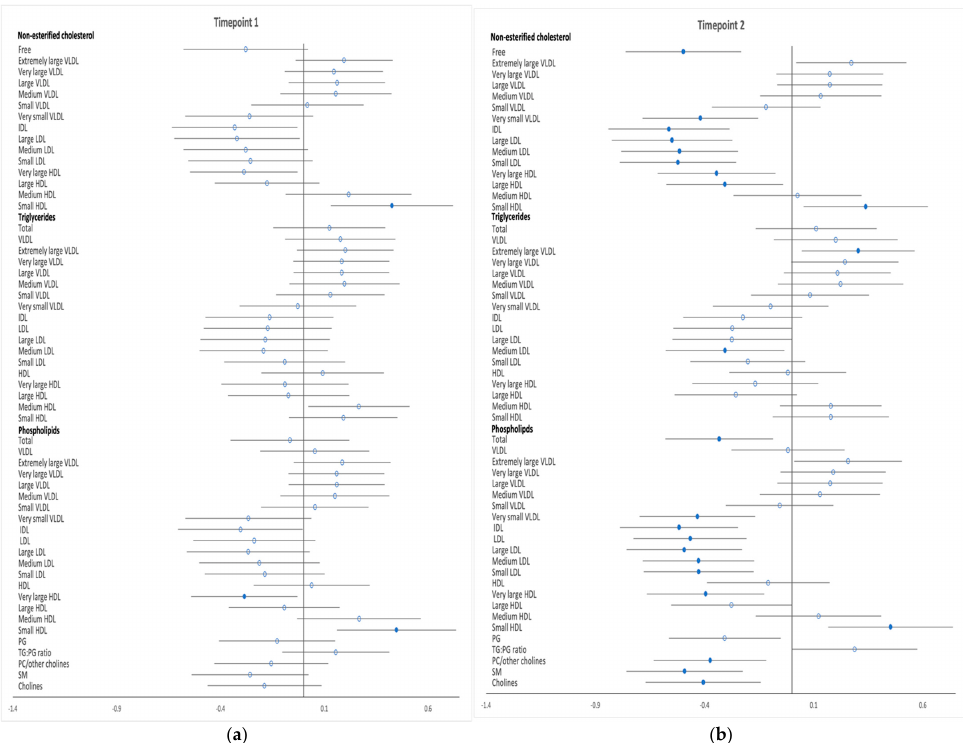
Figure 2. Differences in non-esterified cholesterol, triglycerides and phospholipids between high − -risk women who developed GDM and those who did not develop GDM at timepoints 1 ( a ) and timepoint 2 ( b ). Data points show the SD difference at baseline (timepoint 1) and at the time of OGTT (timepoint 2). Positive associations with GDM are shown to the right, negative associations are shown to the left. Closed blue circles represent FDR corrected p values of < 0.05. PC, phosphatidyl- cholines; PG, phosphoglycerides; SM, sphingomyelins; TG:PG, triglycerides: phosphoglyceride.